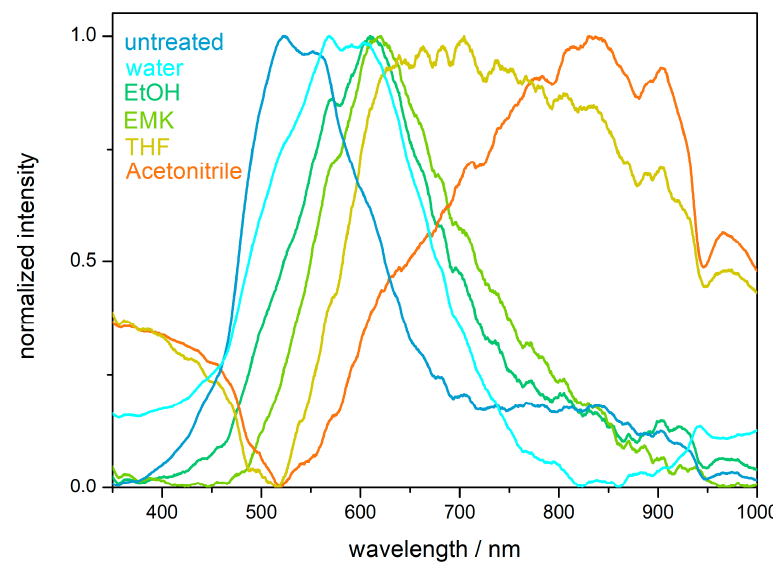
Figure 10. UV/Vis reflection spectra of solvent-treated inverse opal film based on P(TFEA- co - NFHMA- co - i BuMA). Abbreviations: ethanol (EtOH), ethyl methyl ketone (EMK),